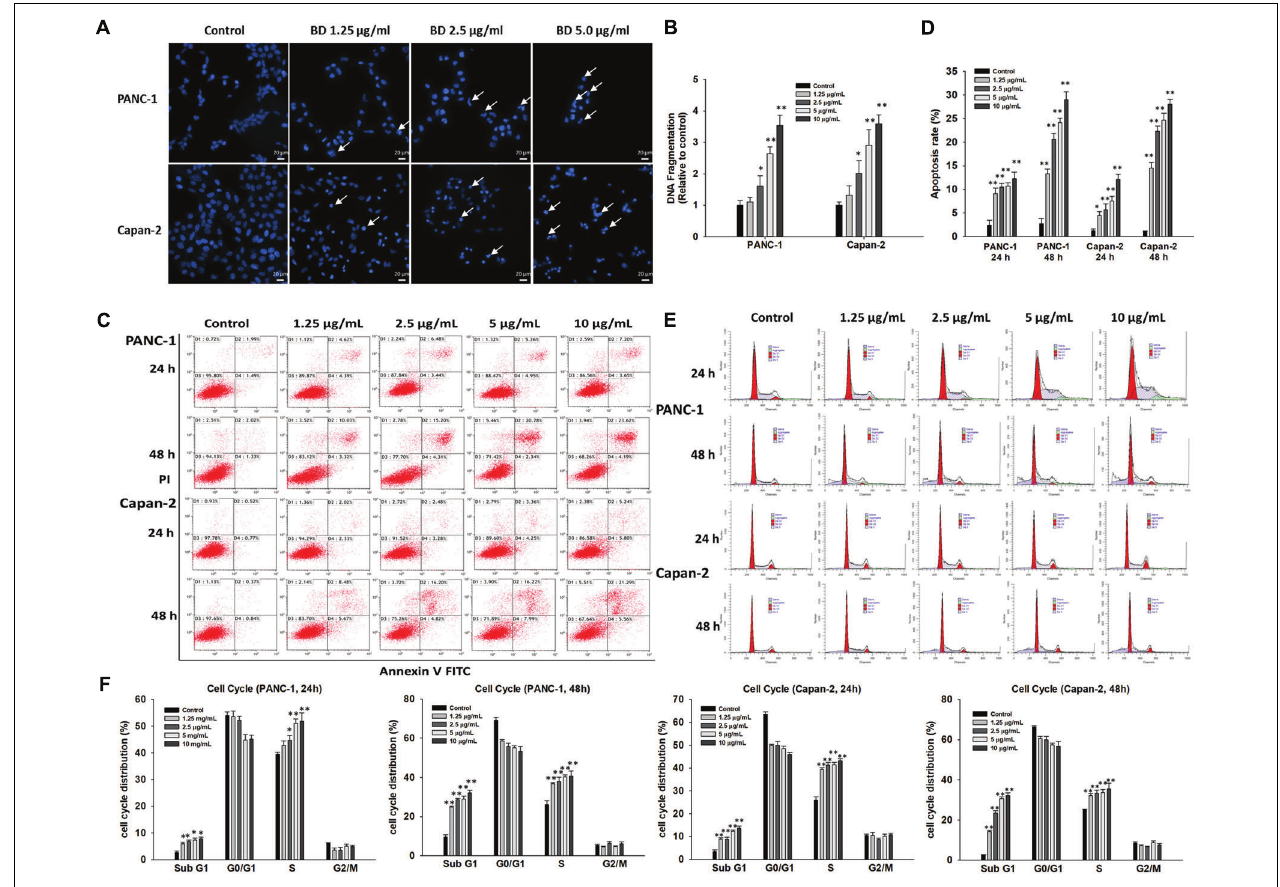
FIGURE 2 | BD elicits apoptosis and S-phase arrest in PANC-1 and Capan-2 cells. (A) PANC-1 and Capan-2 cells were subjected to cell nucleus morphological analysis using Hoechst 33342 after different concentrations of BD (1.25, 2.5, and 5 µ g/mL) treatments for 48 h. Representative fluorescence images of Hoechst 33342 positive cells are shown. Scale bar, 20 µ m. (B) Cells were treated with various concentrations of BD (1.25, 2.5, 5, and 10 µ g/mL) for 72 h, followed by Cell Death Detection ELISA assay. (C,D) Cells were exposed to different concentrations of BD (1.25, 2.5, 5, and 10 µ g/mL) for 24 and 48 h, followed by flow cytometry apoptosis assay. Bar graphs show the proportion of early and late apoptotic cells. (E,F) Cells were treated with BD (1.25, 2.5, 5, and 10 µ g/mL) for 24 and 48 h, and the cell cycle phases were evaluated by flow cytometry. Each bar represents means ± SD of three separate experiments. ∗ P < 0.05 and ∗∗ P < 0.01 vs the control